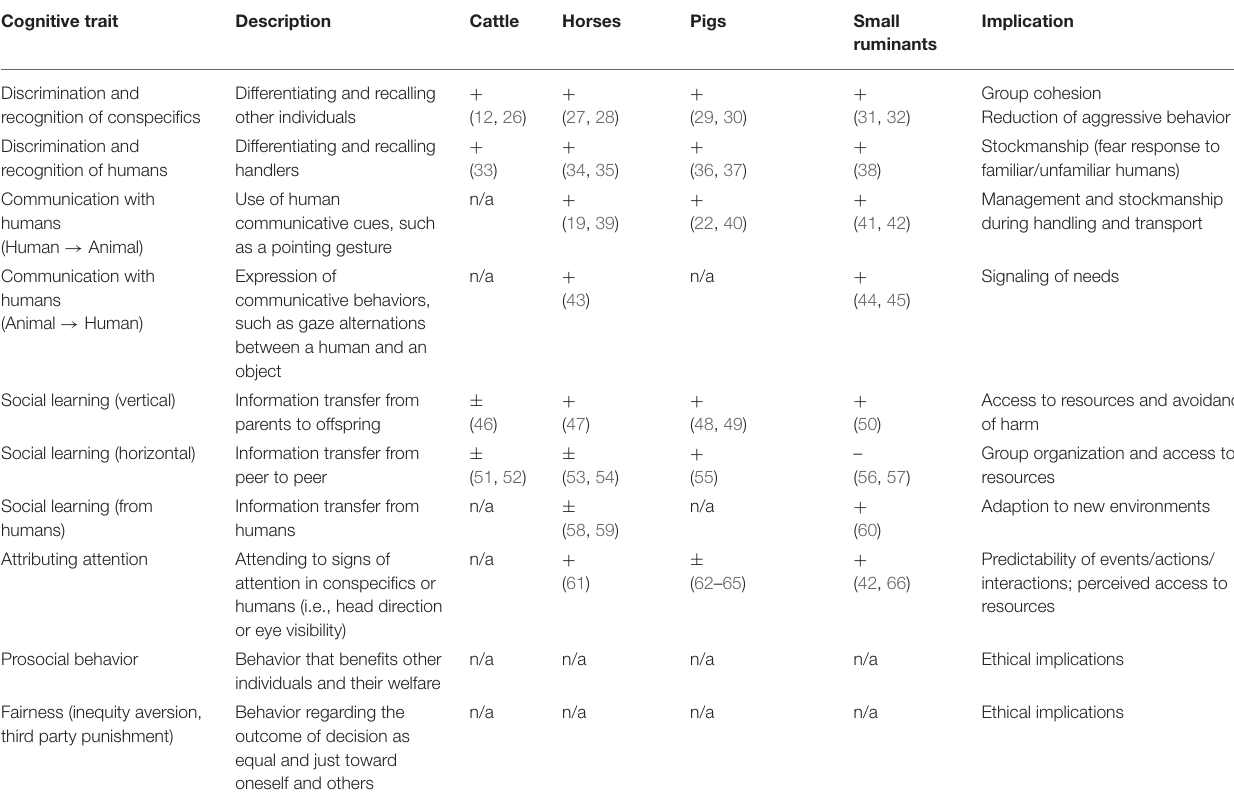
TABLE 2 | Overview on various socio-cognitive capacities, their description, evidence in different farm animals, and their implications. Cognitive